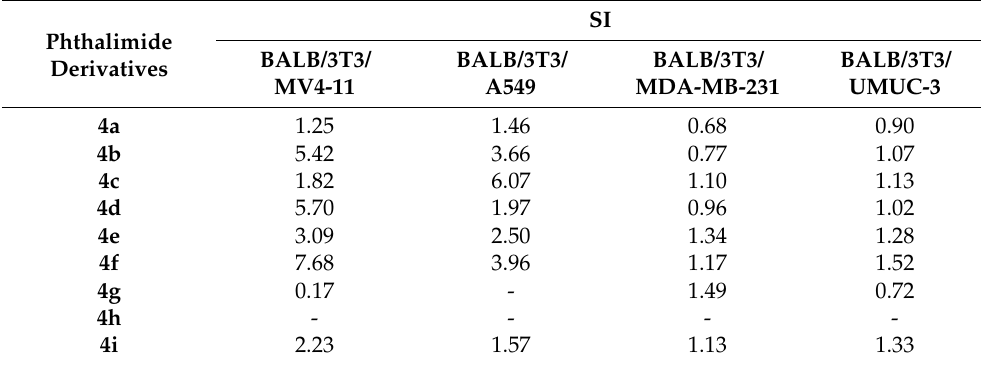
Table 4. The calculated selectivity index (SI) of tested compounds. The SI index = IC 50 of compound in a normal cell line/IC 50 of the compound in cancer cell